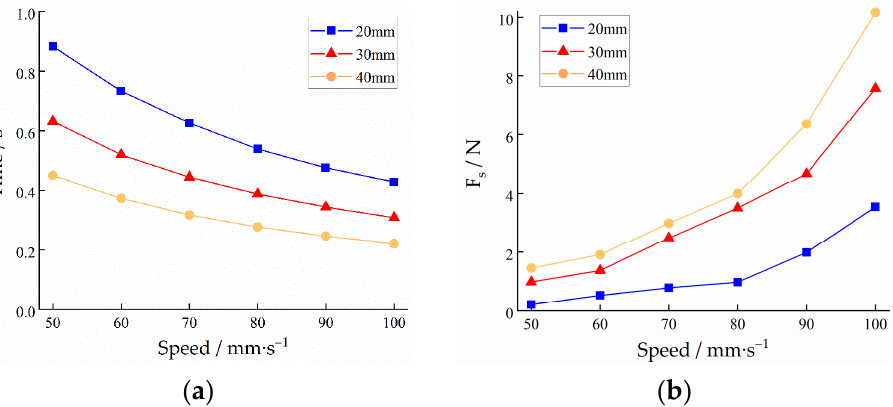
Figure 10. The simulation results: ( a ) the relationship between speed and time; ( b ) the relationship between speed and 𝐹 (cid:3046) .